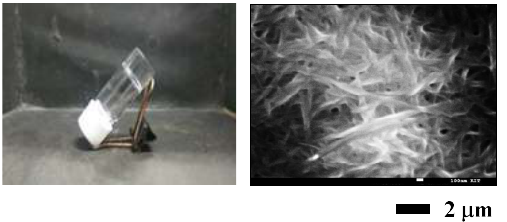
Figure 2. Optical and SEM images of gel from 6d and 9 in chloroform.